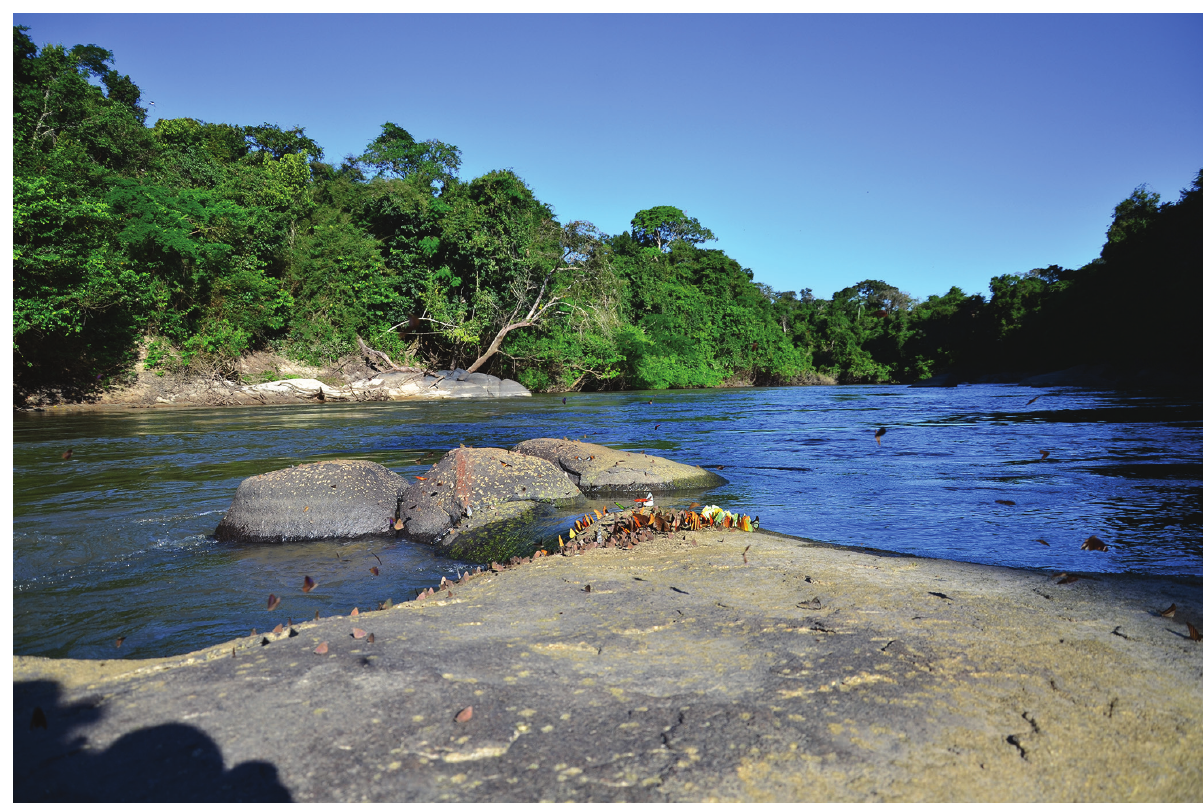
Fig. 6. Type locality of Aphanotorulus rubrocauda , Brazil, Amazonas State, Apuí Municipality, boulders on rapids 40 minutes above of the Comil farm, rio Madeirinha, rio Aripuanã basin. Photo by Willian